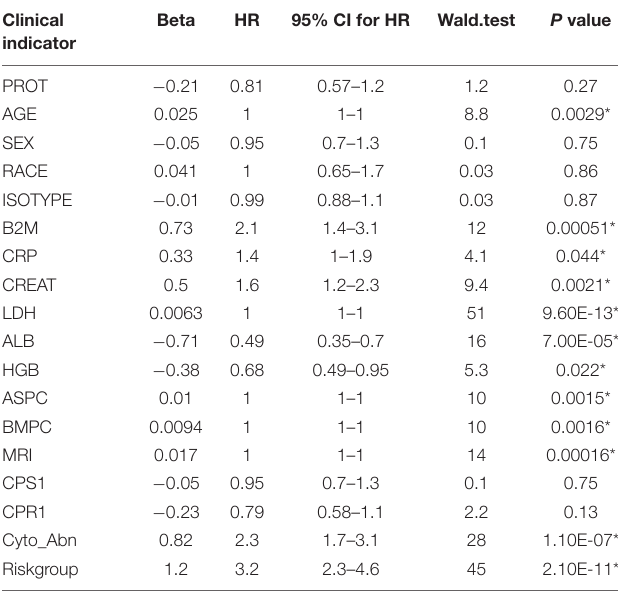
TABLE 1 | Univariate Cox regression analysis of all clinical indicators and the five-gene risk group. Clinical